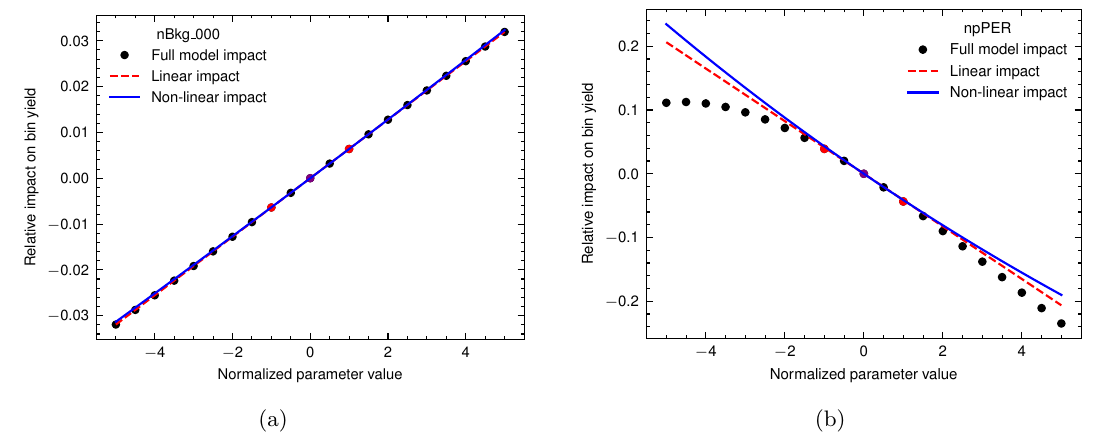
Figure 7 . Relative change in expected bin yields as a function of the normalized parameter value for two cases: (a) the impact of the background normalization parameter nBkg_000 on the expected background yield; and (b) the impact of the photon energy resolution parameter npPER on the expected signal yield. In both cases, the bin belongs to the first category of the model and is located at m 127 GeV, about 0 . 7 σ above the signal peak. The impacts computed from the full model γγ ≈ (dots) are compared with the linear impacts computed from eq. (2.2) (dashed red line) and the non-linear impacts from eq. (2.6) (solid blue